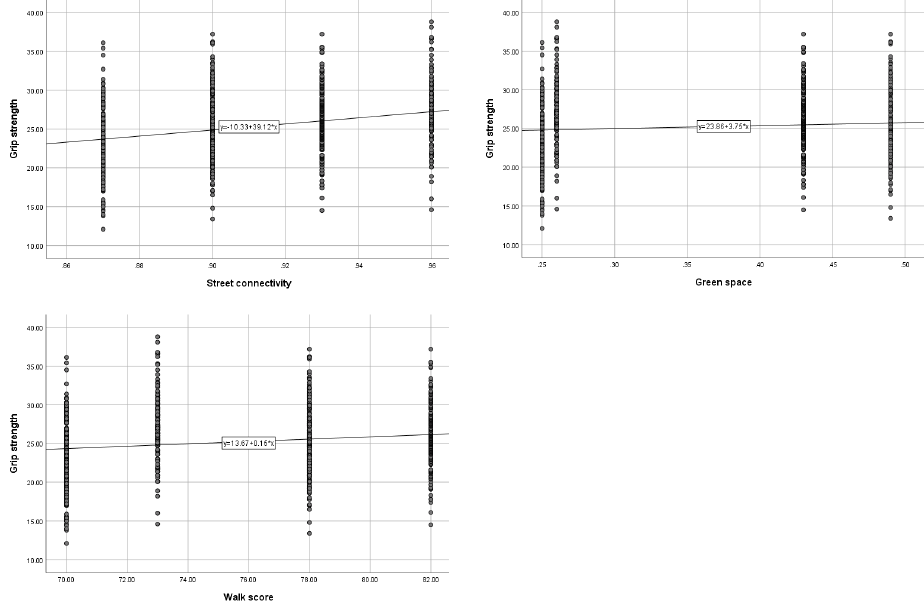
Figure A4. The specimen scatterplots for correlation between grip strength and built environment in female students.